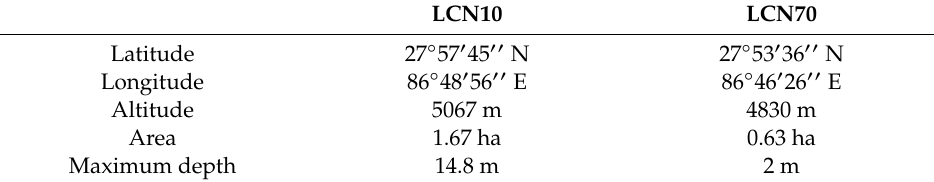
Table 1. Geographic coordinates and principal morphometric characteristics of the studied lakes.